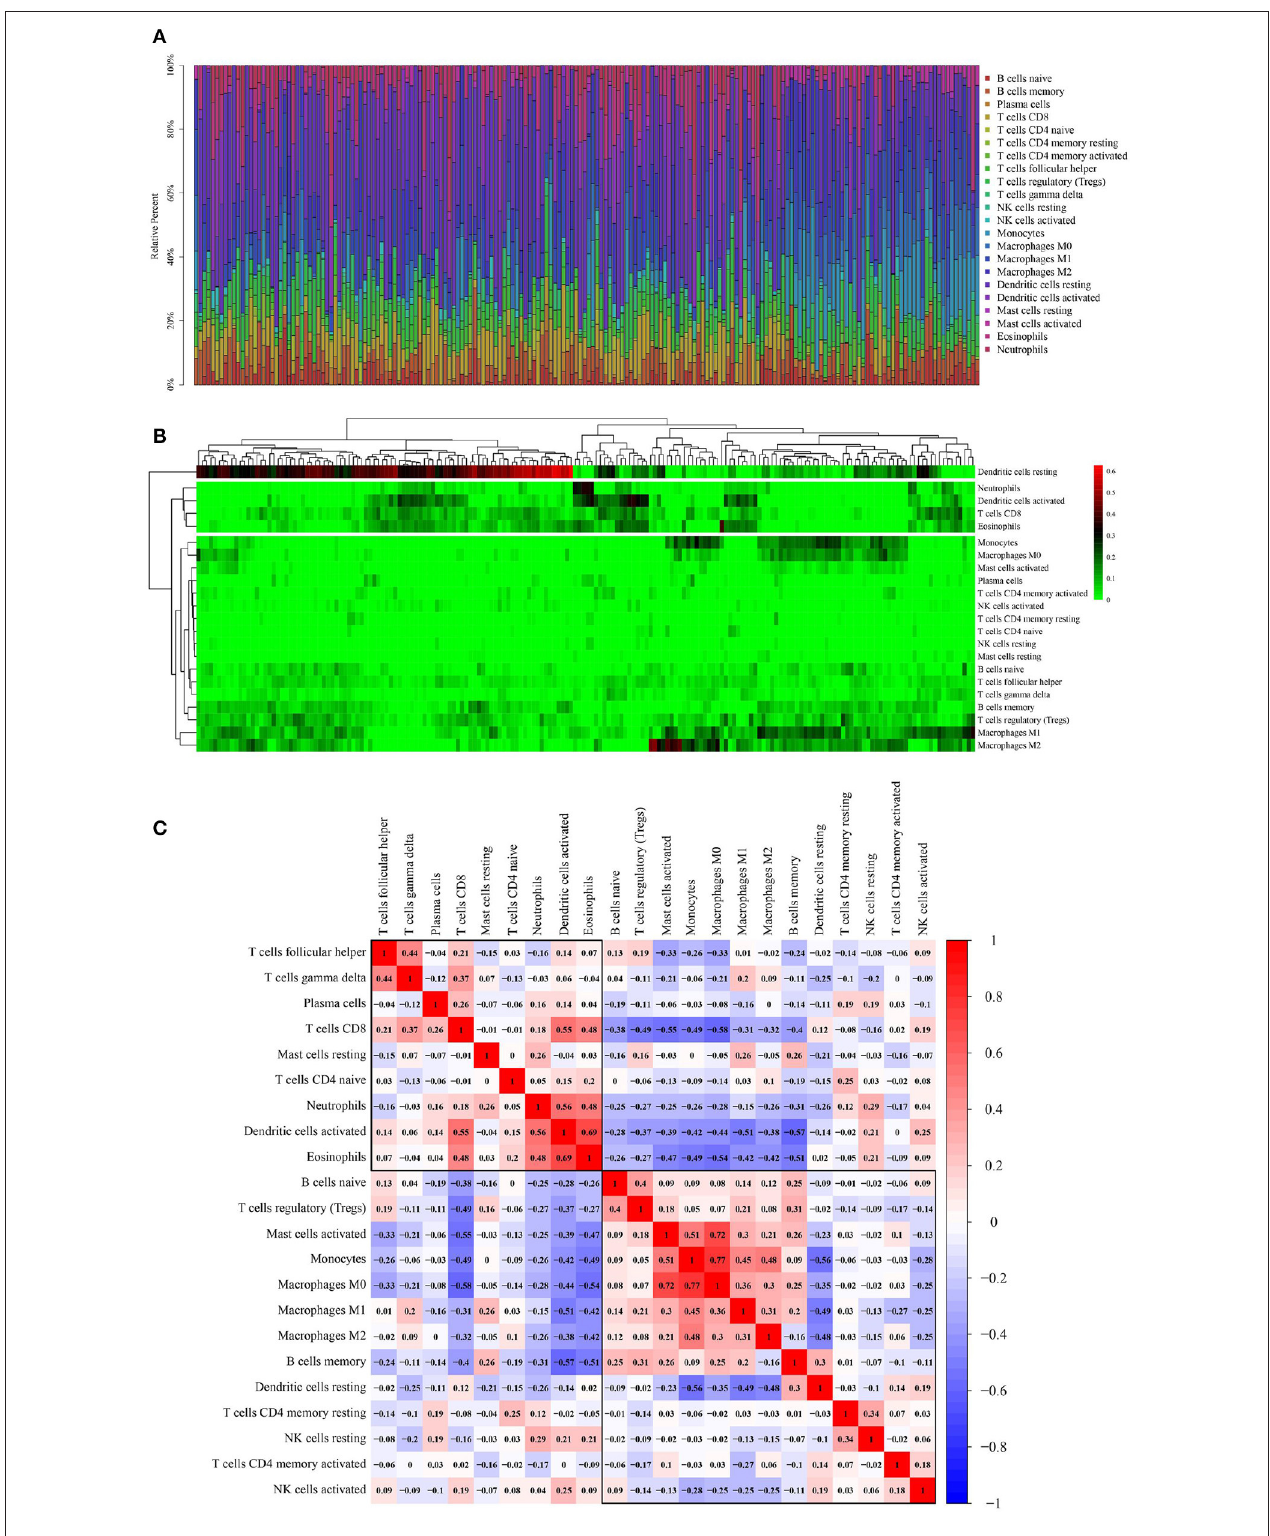
FIGURE 2 | Performance of CIBERSORT ascertained TIICs in OSCC. (A) The distribution of 22 TIICs in OSCC samples. X-axis represents the name of 115 samples, and y-axis represents the composition ratio of the cells in each sample. Different colors represent different types of cells. The longer column of each cell in a certain sample indicates that the proportion of this type of cell is higher in this sample. (B) A heat map of the 22 TIICs proportions in 115 OSCC samples. Each column